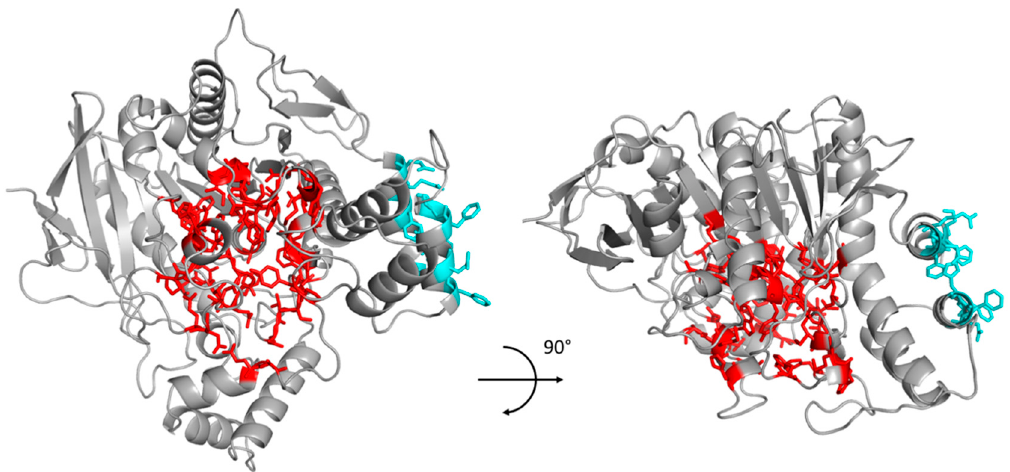
Figure 1. Structural representation of the selected conserved residues of human butyrylcholinesterase (hBChE) for the PROSS process. Residues conserved in order to preserve enzymatic activity are represented in red, those conserved to maintain dimer interaction are represented in cyan.